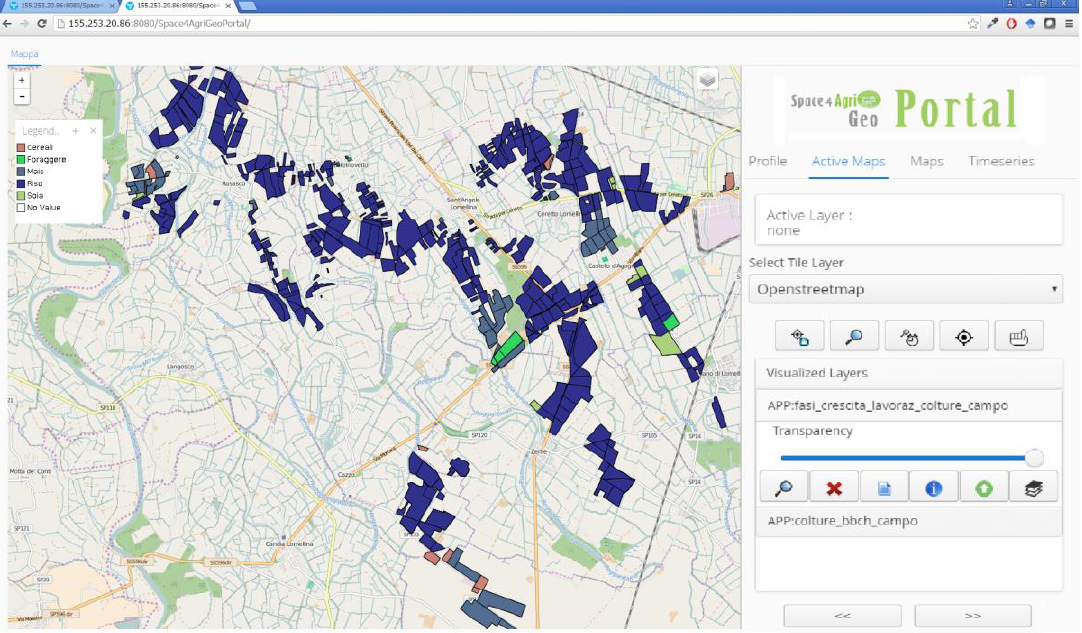
Figure 5. S4A geoportal showing a GD layer of in-situ observations of crop types created by the use of the S4A Smart App (source: own processing).